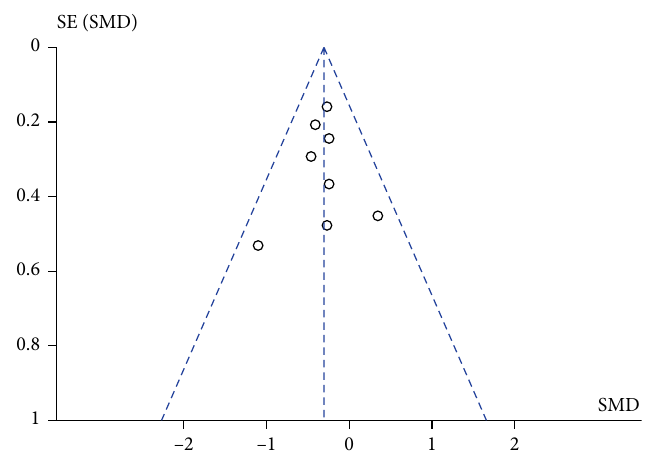
Figure 4: Funnel plot of eight studies that performed an intervention of 10 to 35 training sessions with muscular strength exercises.